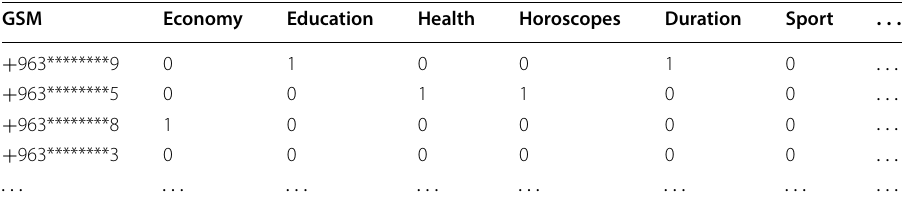
Table 2 Example of customer’s services in Syriatel